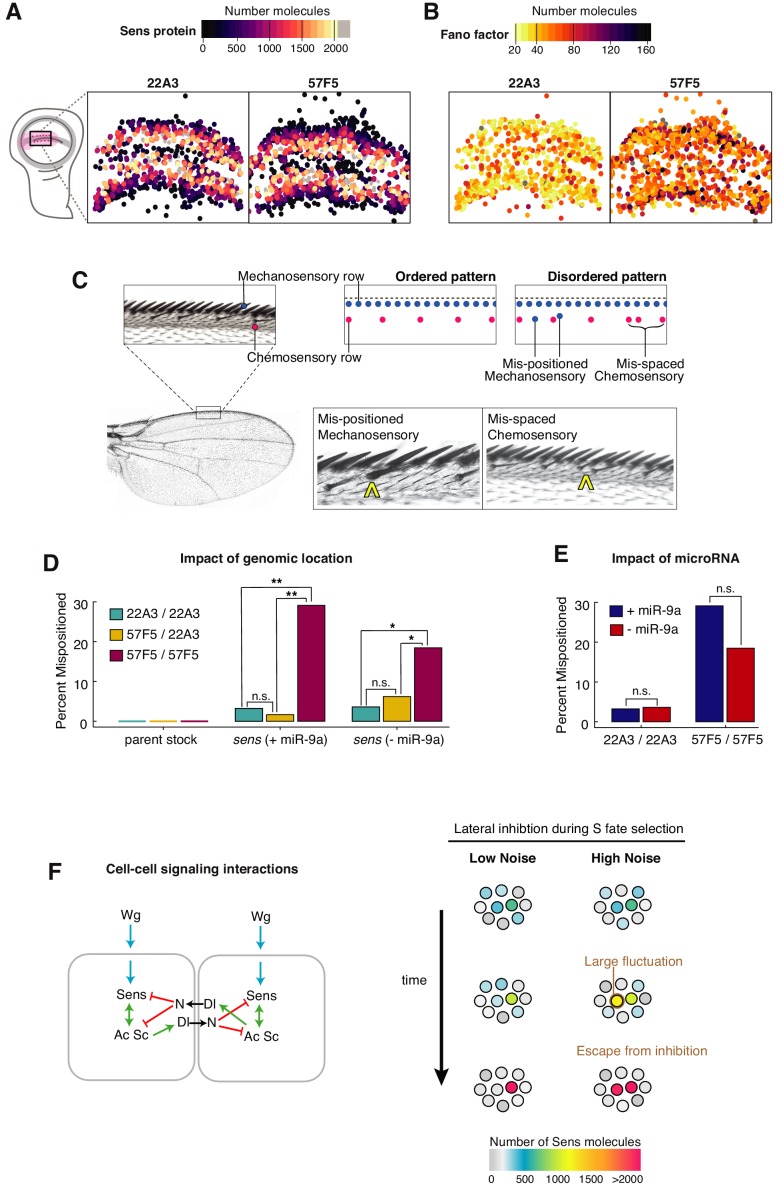
Self-organized sensory patterning is disrupted by stochastic gene expression.(A, B) The centroids of Sens-positive cells in 22A3/22A3 and 57F5/57F5 wing discs are mapped and color coded according to Sens protein number (A), and Fano factor level (B). Cells exhibiting high Fano factor values are distributed throughout the proneural zone of the 57F5/57F5 disc, where S fate determination occurs (see also Figure 7—figure supplements 1 and 2). (C) The dorsal surface of the adult wing margin displays two ordered rows of sensory organs - an outer continuous row of thick mechanosensory bristles (blue) and an inner periodic row of thin chemosensory bristles (magenta). Disorganized patterns are observed when bristles are incorrectly positioned. Instances of ectopic (mis-positioned) mechanosensory bristles in the chemosensory row (center) and ectopic chemosensory bristles, which disrupt periodic spacing (right), were observed and counted. (D) Percentage of adult wings with one or more patterning error. Pattern disorder is much greater when sens alleles are expressed from 57F5/57F5 relative to alleles at 22A3/22A3 or 57F5/22A3. This result is observed regardless of whether miR-9a regulates sens or not. Genotypes were compared by calculating the odds ratio of mispatterning, and determined to be significantly different from one if p<0.05 using a Fischer’s exact test: n.s., not significant; *p<0.05; **p<.005 (Figure 7—figure supplement 3). (E) Uniformly increasing Sens protein number 1.8-fold by removing miR-9a regulation does not lead to greater pattern disorder. Genotypes were compared by calculating the odds ratio of mis-patterning, and determined to be significantly different from one if p<0.05 using a Fischer’s exact test: n.s., not significant (Figure 7—figure supplement 3). (F) Left: A schematic outlining the induction of sens by Wg (blue) followed by sens auto-activation through feedback with Ac Sc (green) and through mutual inhibition between neighboring cells (red). Right: When expression noise is sufficiently small, Sens levels progressively increase or decrease in neighboring cells. However, when noise is enhanced, a large fluctuation will alter the trajectory of Sens expression towards an erroneous outcome.Figure 7—source data 1.Odds ratio of wings with mispositioned mechanosensory bristles.For each genotype, the proportion of wings containing at least one ectopic mechanosensory bristle was calculated. To compare between two genotypes, the odds ratio (of wings with ectopic bristles) was calculated from these proportions. Test column indicates the variable being compared (genomic locus of sens alleles, or presence of miR-9a binding sites in the sens 3’UTR) across each subgroup. Fisher’s exact test was used to determine if the odds ratio was not equal to 1. Odds ratios significantly different from one are highlighted in bold (*p-value<0.05, ** p-value<0.01, *** p-value<0.005, p-value>0.05, not significant).